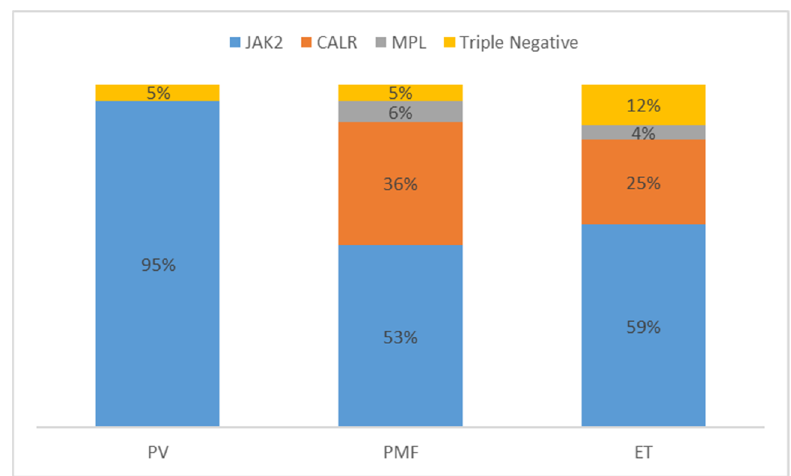
Figure 1. Adapted from [17] showing the frequency of each driver mutation in Myeloproliferative neoplasms (MPN) relative to the disease phenotype.